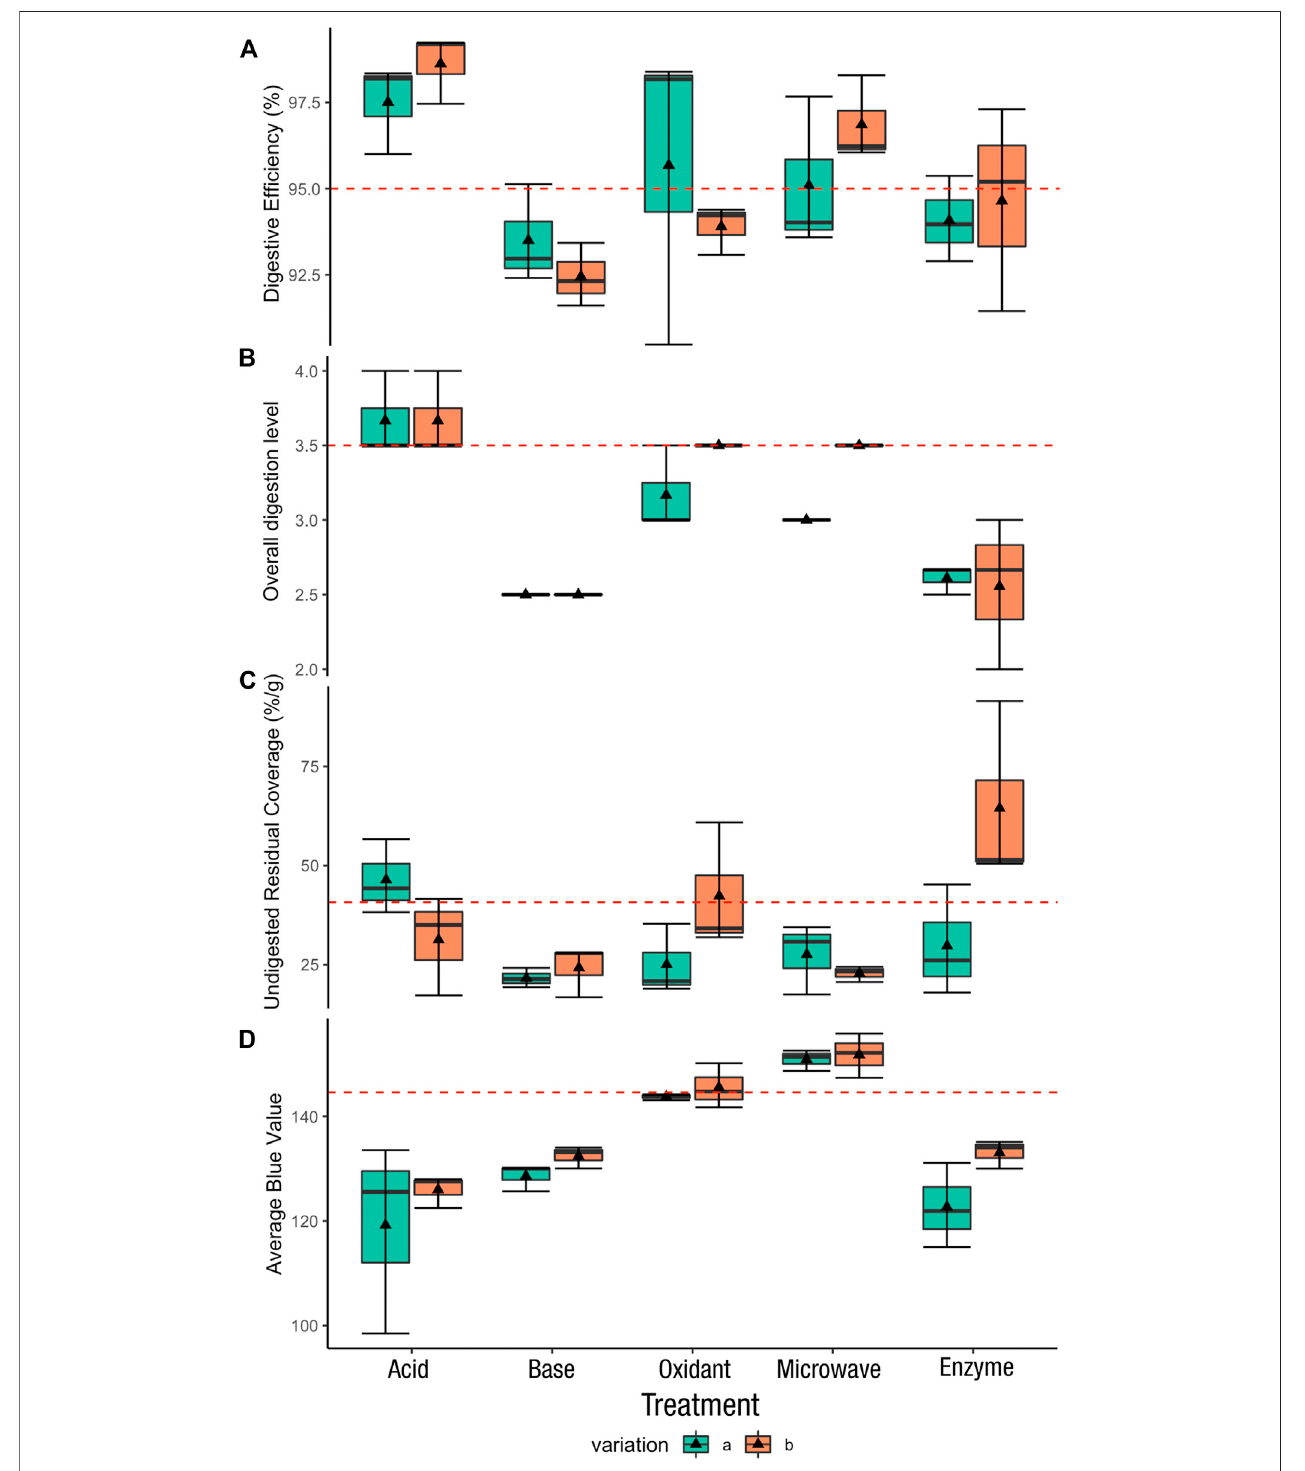
FIGURE 5 | Boxplot for all evaluated aspects. The triangle marker is the mean value of each treatment. The red dash line is the cut-off line: (A) digestive ef fi ciency — 95% adopted from (Karami et al., 2017), (B) normalized overall digestion level — Q3 = 3.5, (C) undigested residue coverage — Q3 = 40.7%, (D) average blue value — Q3 =